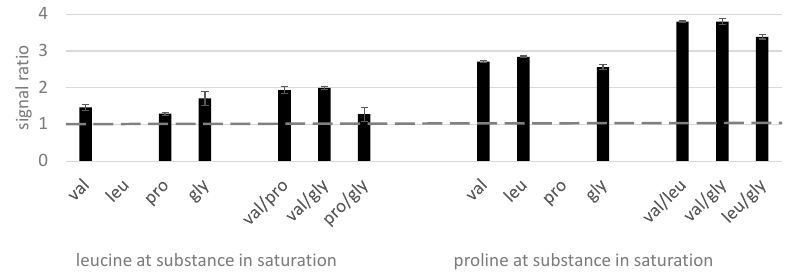
Figure 4. Relative recovery of the amino acids leucine and proline (350 µM) in presence of saturated valine, leucine, proline, and glycine (10 mM) and their different pairings presented in order of their retention time with leucine and proline included to illustrate the observed elution order. Analyzed on an Agilent GC 6890.